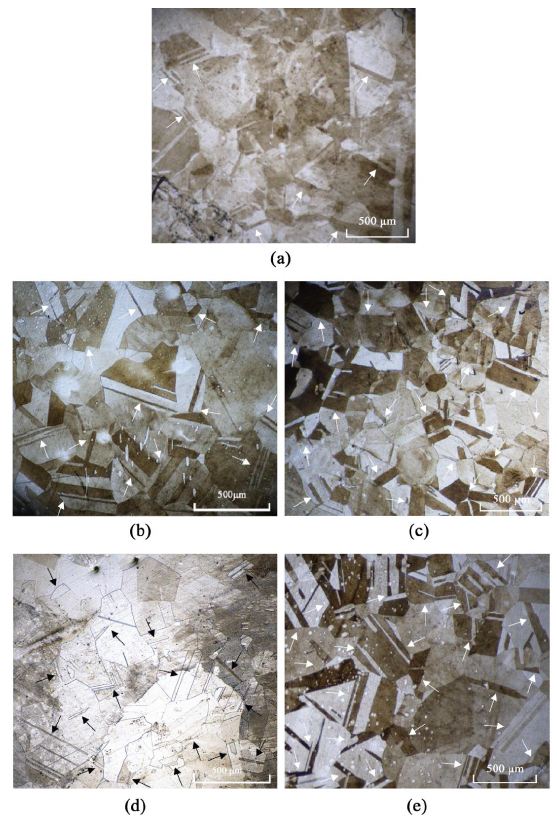
Figure 7. Microstructure of FeNiCoCr HEA samples annealed at different temperatures: ( a ) Initial, ( b ) 600 ◦ C, ( c ) 750 ◦ C, ( d ) 850 ◦ C and ( e ) 1000 ◦ C. Arrows in ( a – e ) mark annealing